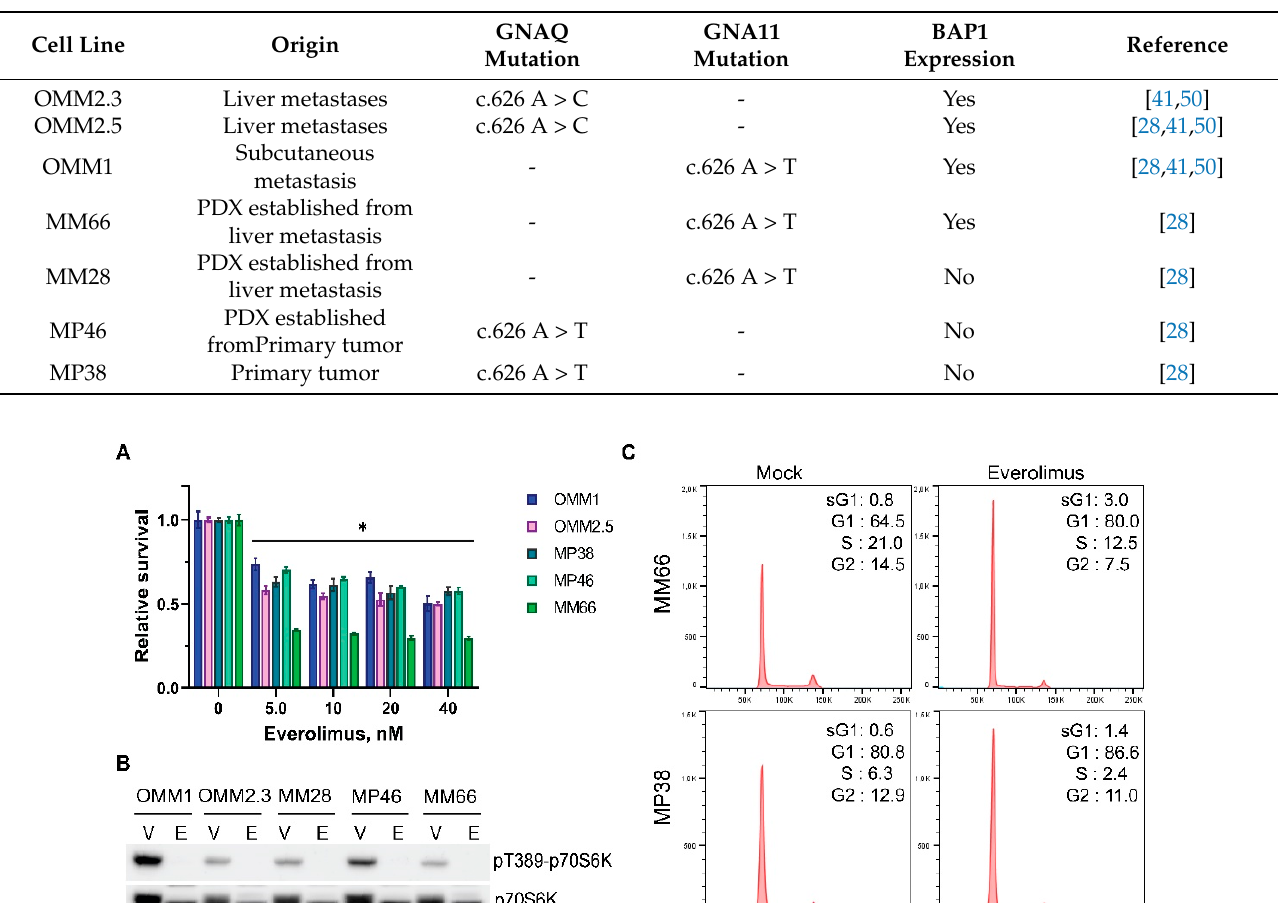
( A ) The effect of various concentrations of everolimus on growth of UM cell lines after 5 days of treatment. Significant reduction ( p < 0.05) of viability compared to a control is indicated with (*). Statistical analysis was performed using a one-way ANOVA with Dunnett’s test for multiple comparisons. Error bars present means ± SEM. ( B ) Treatment with 10 nM everolimus blocks phosphorylation of p70-S6 Kinase at Thr389 after 24 h. The total levels of p70-S6K remain stable. Vinculin represents a loading control. V: vehicle, E: everolimus. ( C ) Treatment with everolimus (10 nM for